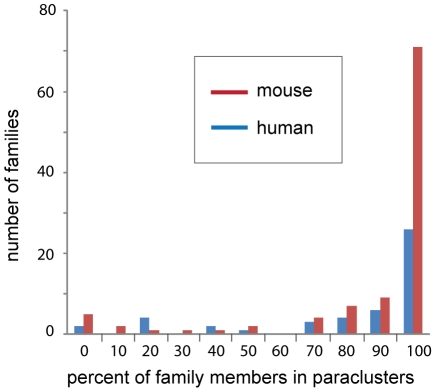
Extent of clustering within gene families.Frequencies of Ensembl gene family counts grouped by the percentage of family members contained within paraclusters (only families with 10 or more family members were counted).